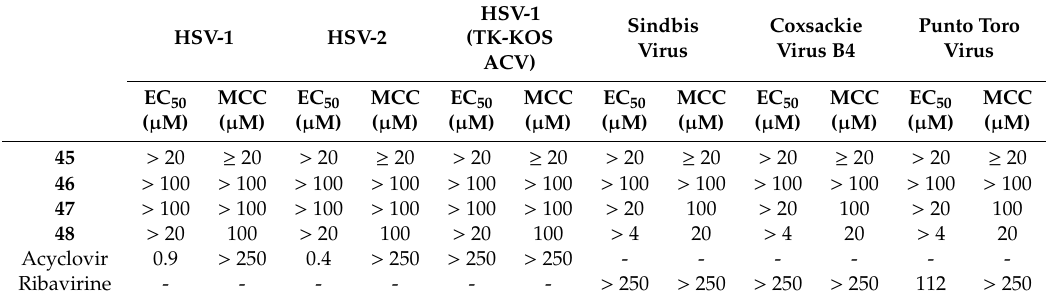
Table 6. Antiviral evaluation and in vitro cytotoxicity of compounds 45 – 48 (adapted from [49]).